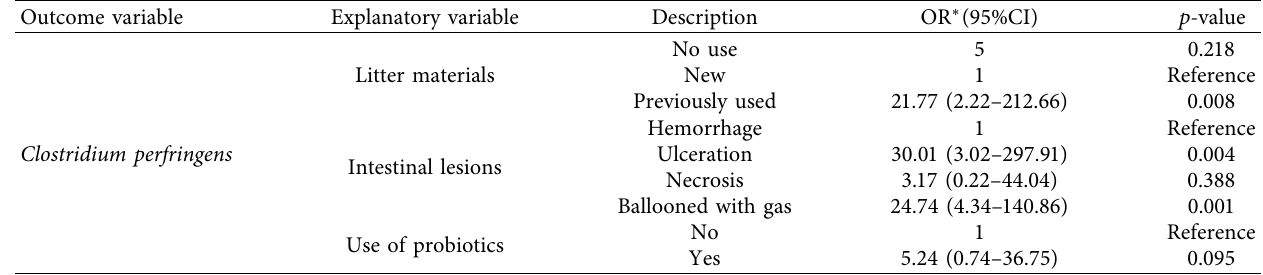
Table 4: Multivariable logistic regression analysis of risk factors for the presence of C. perfringens in diseased chicken. Outcome